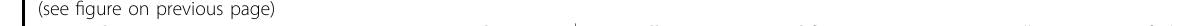
Fig. 5 Cluster 2-Mesen_CAF, Macro_APOE/NRG1 and TNFRSF4 + Treg cells were increased from DN to T stage. a Cell proportions of Cluster 2-Mesen_CAF (Cluster 2-Mesen_CAF/CAF) in patients of T stage compared with N + DN stages by scRNA-seq data. b Violin plot displaying Cluster 2 marker gene expressions in Cluster 2-Mesen_CAF, other clusters in Mesen_CAF and In fl a_CAF. Two-sided Wilcoxon rank-sum tests for analyzing the signi fi cance of their differences. *** P < 0.001. c Statistical results showing proportions of ( IGFBP3 , POSTN ) positive points in different tissue regions by ST analyses. A two-tailed unpaired Student ’ s t test for t he P values. * P < 0.05. d The line charts showing changes of (Macro_APOE/NRG1) cell proportions in each individual from DN to T stage. A two-tailed paired Student ’ s t test for the P values. * P < 0.05. e Heatmap showing enrichment Macro_APOE/NRG1 and degrees of M1/M2/angiogenesis/glycolysis/ROS pathways by comparison of their marker genes expression levels in different distributions of ST samples. Each row shared a color scale, while different columns did not. f Pearson correlation plot showing signi fi cant positive correlation of Macro_APOE/NRG1 proportion to average CTSC expression in the epithelial cells. Cor.test() was used for conducting correlation and the statistical analyses. g Volcano plots showing strikingly DEGs between TNFRSF4 + Tregs and TNFRSF4 − Tregs. h Violin plots showing the metagene expression of the IL2-STAT5 signaling in TNFRSF4 + and TNFRSF4 − Tregs. P value was calculated by Wilcoxon test. i Cell proportions of TNFRSF4 + Treg cells in patients of diverse initiation stages by scRNA-seq data. j Proportions of cell number ratios of CD8_Tem cells to CD4_TNFRS4 + Treg cells in patients by scRNA-seq data. k ST feature plots of P1 and P2 showing expression of TNFRSF4 in different distributions. l Statistical results showing proportions of TNFRSF4 positive points in different tissue regions by ST analyses (right). m mIHC staining of APOE, CD68, FOXP3, OX40 (TNFRSF4) and panCK in one patient of diverse initiation stages. Scale bars: 500 μ m. The numbers in images indicated (CD68 + &APOE + ; FOXP3 + &OX40 + ) double- positive cell proportions among corresponding CD68 + and FOXP3 +